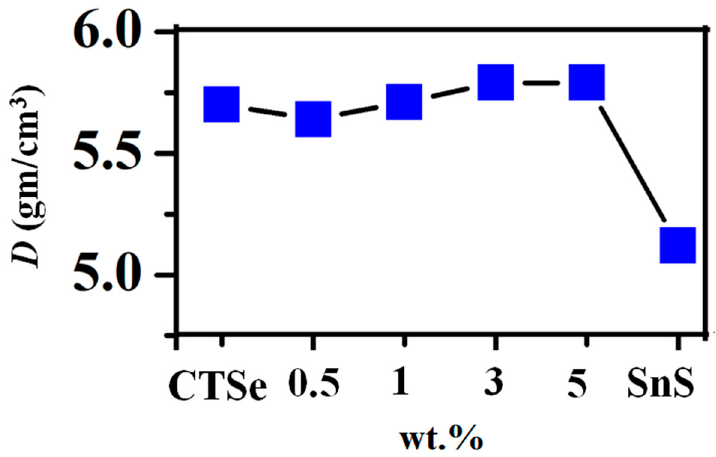
Figure 4. Density of the spark plasma sintered Cu 2 SnSe 3 , SnS, and Cu 2 SnSe 3 -SnS composites. Each point represents the average of five different readings.